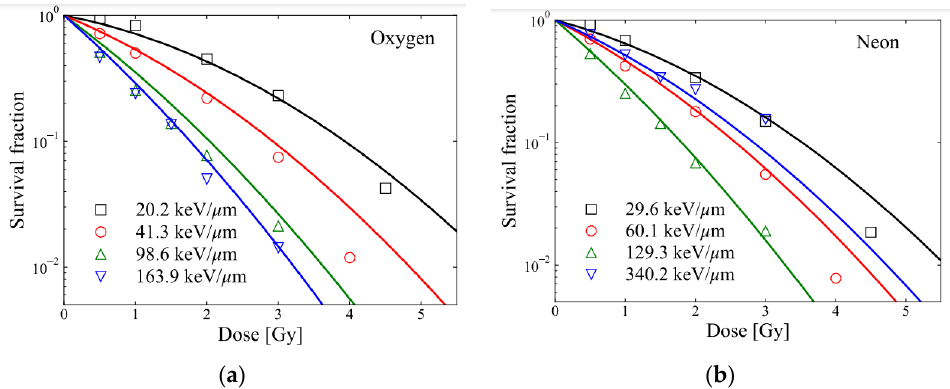
Figure 16. Survival fraction of in vitro data of the MIA PaCa-2 cells (markers) reported in [26] for each LET of pristine ( a ) oxygen, and ( b ) neon ion beams and the survival curves calculated by substituting the physical dose and lineal energy measured using the SOI MicroPlus-Mushroom microdosimeter for the MK model parameters of 𝛼 0 = 0.001 Gy − 1 , 𝛽 = 0.085 Gy − 2 , 𝑅 𝑛 = 6.8 µm, 𝑟 𝑑 = 0.57 µm and 𝑦 0 = 260 keV/µm (solid lines) [27].